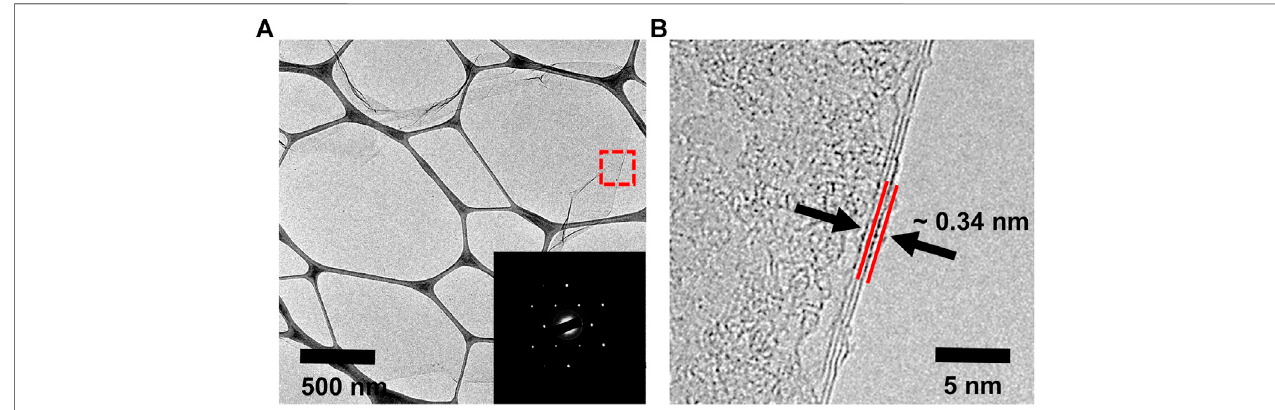
FIGURE 4 | (A) TEM image and SAED pattern (inset) and (B) HRTEM image of the graphene sheet prepared with pH buffer at an initial pH value of 11.